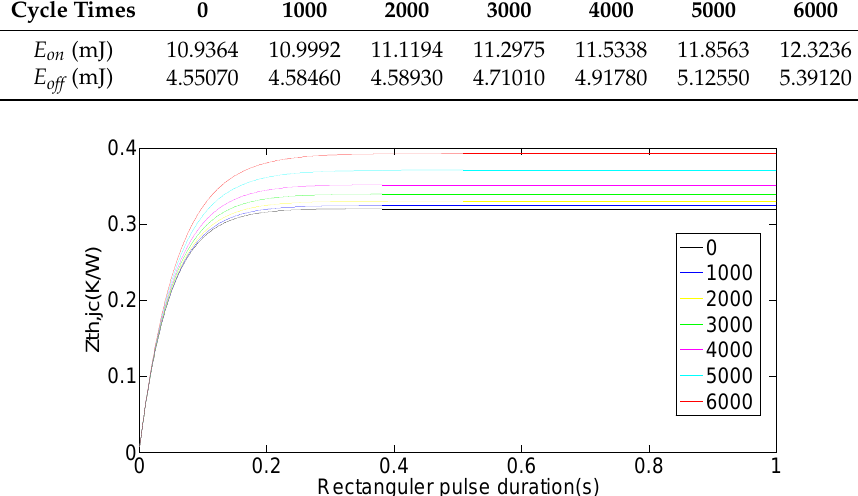
Figure 5. Transient thermal impedance of IGBT at different cycle times. Figure 5 indicated the junction-to-case thermal resistances under different aging states are shown in Table 3. Table 3. The junction-to-case thermal resistance R th,jc of IGBT under different aging states. Cycle Times